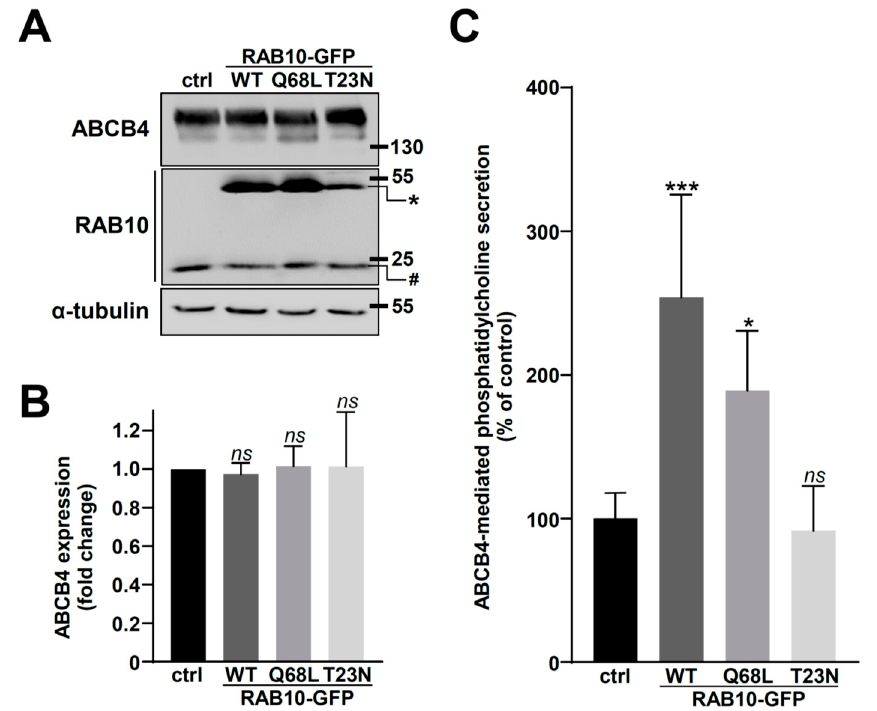
Figure 2. Analysis of ABCB4 expression and function after RAB10 overexpression in HEK cells. ( A ) ABCB4 and the indicated forms of RAB10-GFP were transiently expressed in HEK cells. Empty EGFP-C1 plasmid was used as control (ctrl). Forty-eight hours post-transfection, cell lysates were prepared and analyzed by immunoblot using the indicated antibodies. Molecular weight markers (in kDa) are indicated, as well as endogenous (#) and GFP-tagged (*) RAB10. This panel is representative of three independent experiments. The presented data were cropped from full immunoblots shown in Supplementary Figure S4. ( B ) Densitometry analysis of (A). The amount of ABCB4 was quantified, normalized to the amount of tubulin, and then expressed as fold change compared to the control condition (ctrl). Means (±SD) of three independent experiments are shown; ns: not significant. ( C ) HEK cells expressing both ABCB4 and the indicated forms of RAB10-GFP were used to measure ABCB4-mediated PC secretion. PC secretion was represented as a percentage of the activity for control cells (ctrl, expressing GFP alone) after background subtraction. Means (±SD) of three independent experiments performed in triplicate for each tested condition are shown; * p < 0.05; *** p < 0.005; ns: not significant.